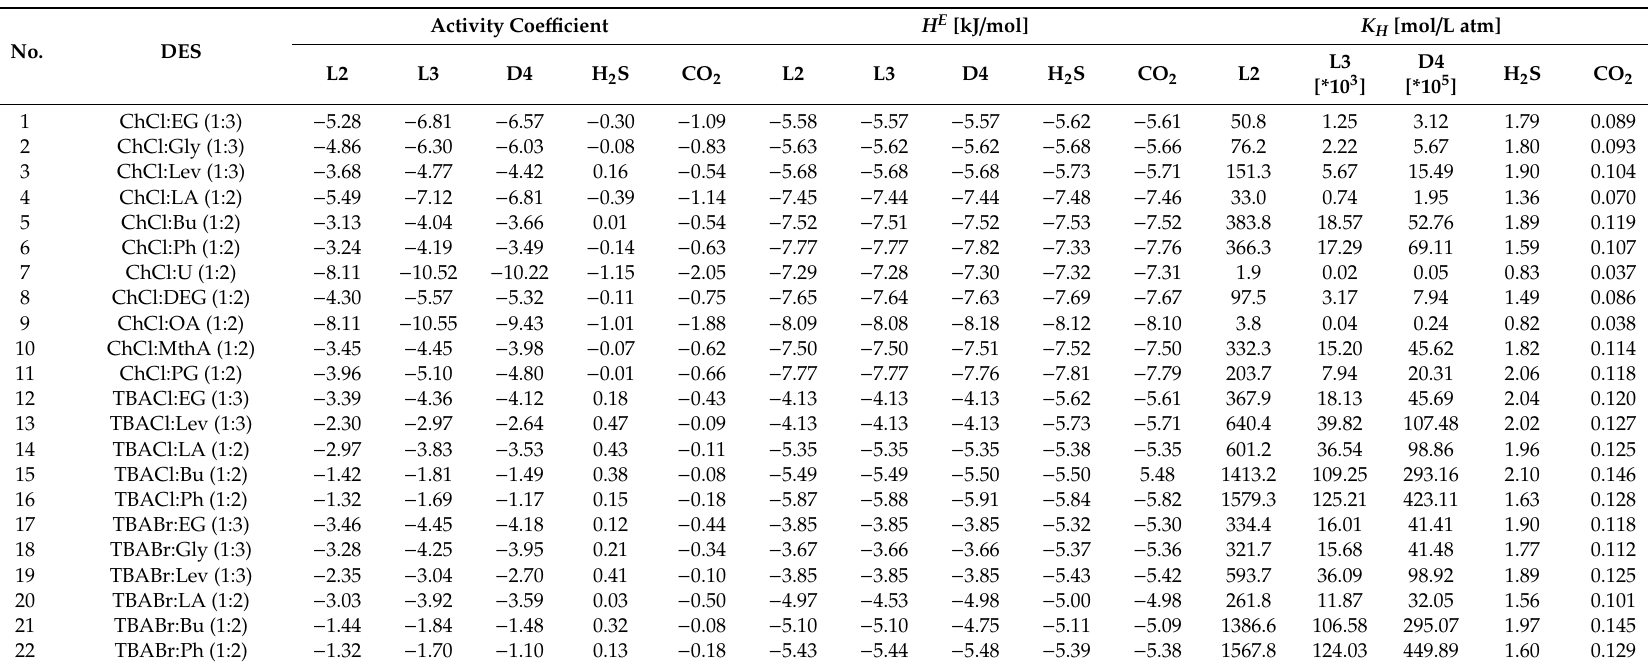
Table 4. The logarithmic activity coe ffi cient of siloxanes H 2 S, and CO 2 model at infinite dilution, excess enthalpy of mixtures and Henry’s constant of siloxanes calculated by COSMO-RS at 20 ◦ C and 101325